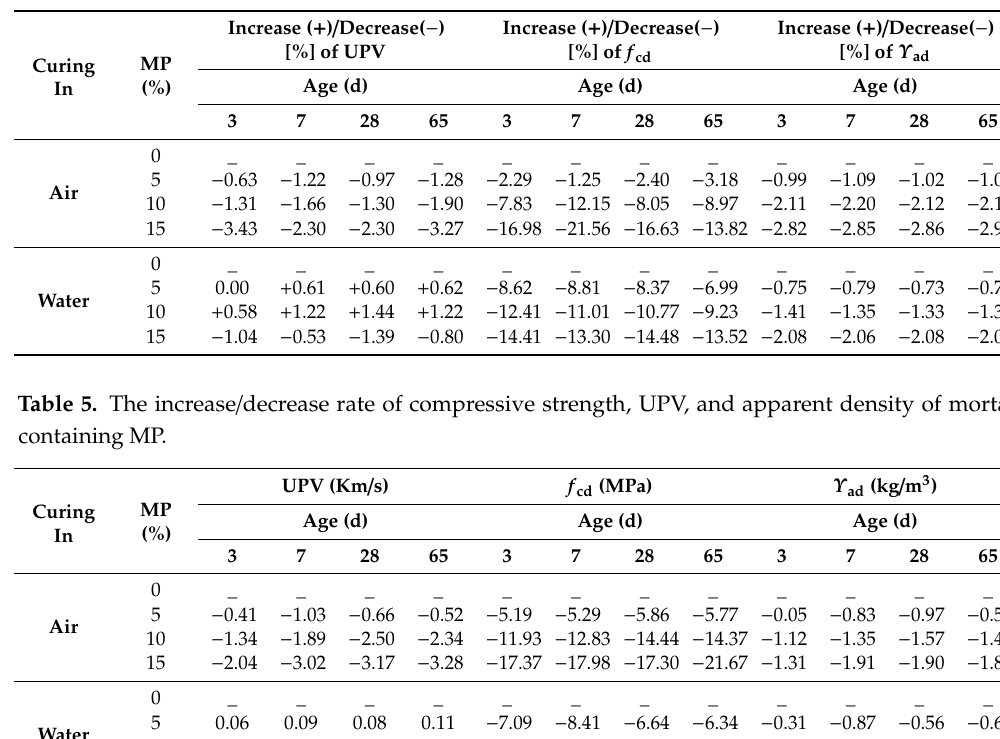
Table 4. The increase / decrease rate of compressive strength, UPV, and apparent density of cement paste containing MP.